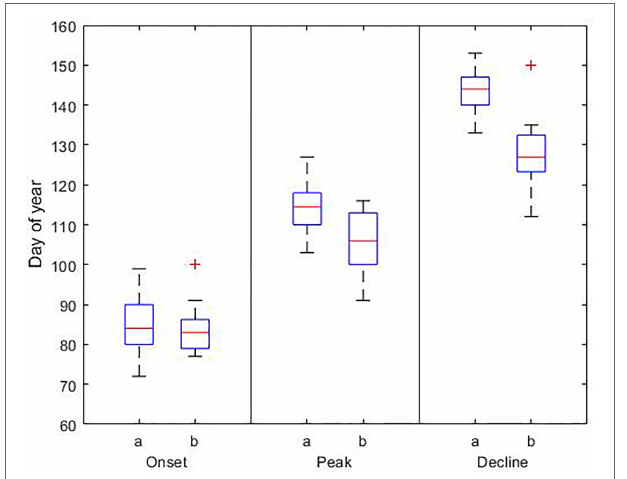
FIGURE 5 | Phenological dates for the diatom bloom based on a) model results (1990-2019) and b) observations (2000-2014). In each box, the central red line indicates the median, and the bottom and top edges of the box indicate the 25th and 75th percentiles, respectively. The whiskers extend to the most extreme data points; outlier observations are marked individually using the ‘+’. Details of the data sets used are reported in Table 3 .